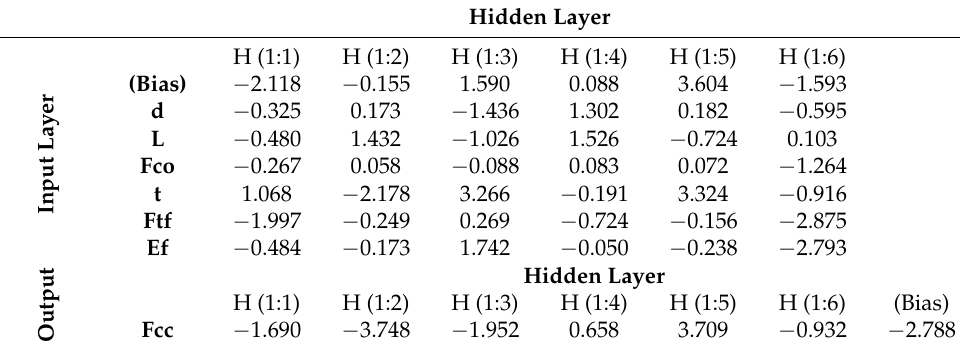
Table 4. Matrix of weights for ANN — GRG network.